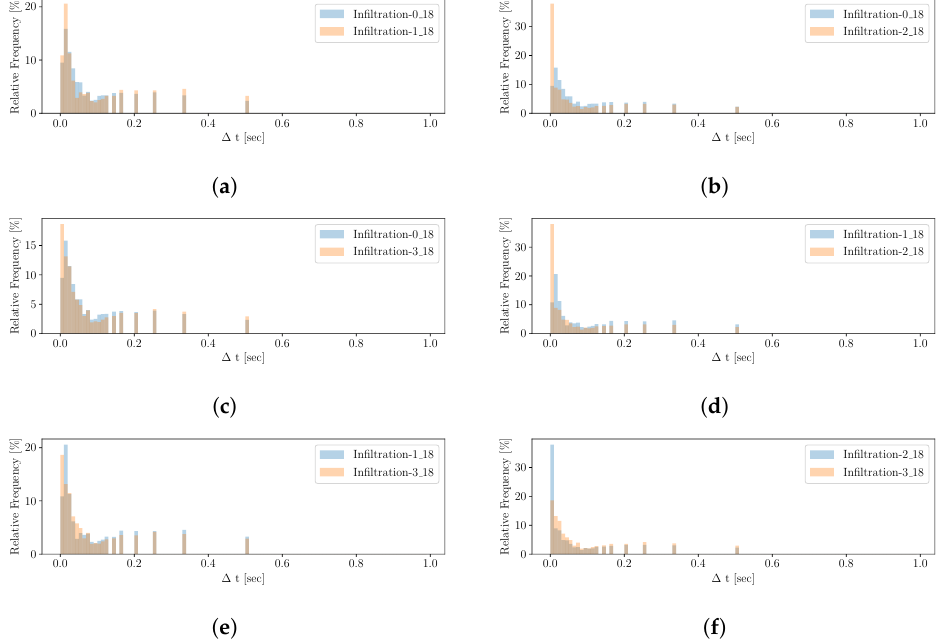
Figure 15. A comparison of ∆ t histograms of four distinct Infiltration attack scenarios ( a – f ) present in CSE-CIC-IDS2018.